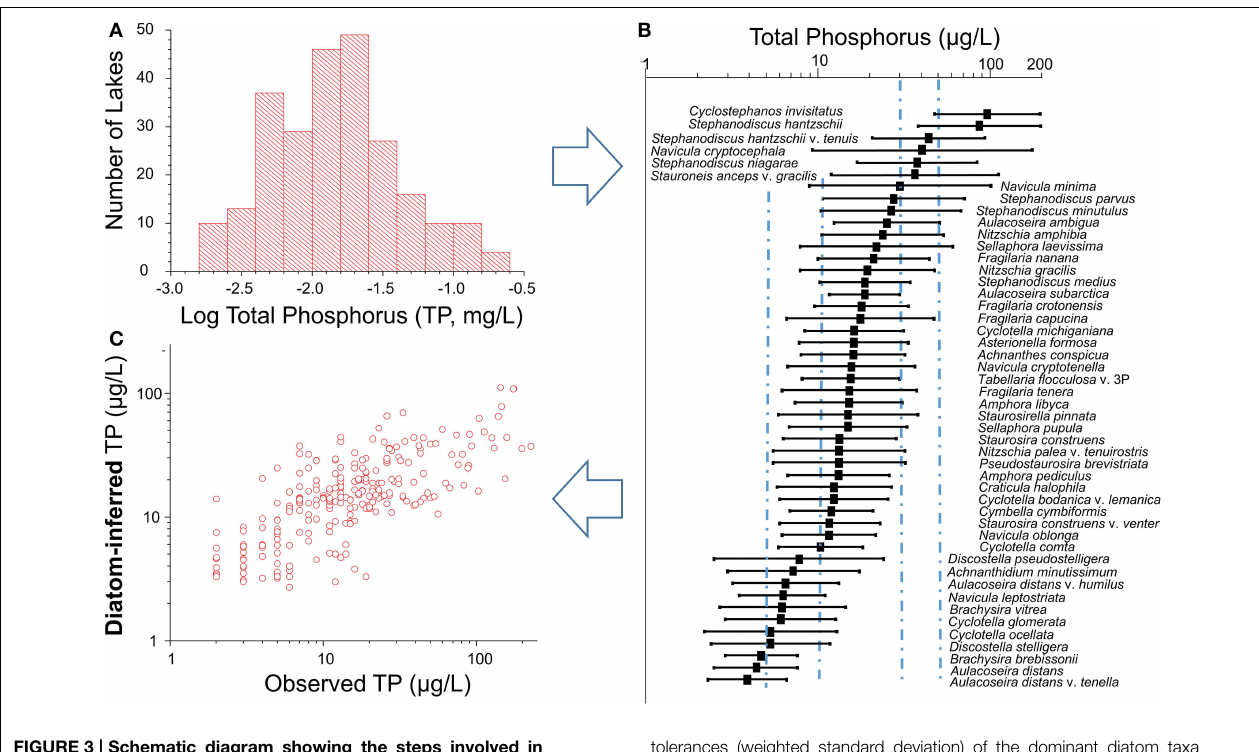
FIGURE 3 | Schematic diagram showing the steps involved in developing a “training” set for inferring lake-water total phosphorus based on the species assemblages preserved in the surface sediments of 251 freshwater lakes from British Columbia. (A) Lakes were selected to span a large gradient of total phosphorus (TP) in freshwater lakes (salinity < 0.5g/L) from which surface sediments were collected and analyzed for diatom assemblages and from which contemporary physical and chemical variables were collected; (B) estimates of the bootstrapped weighted-average optima (square) and